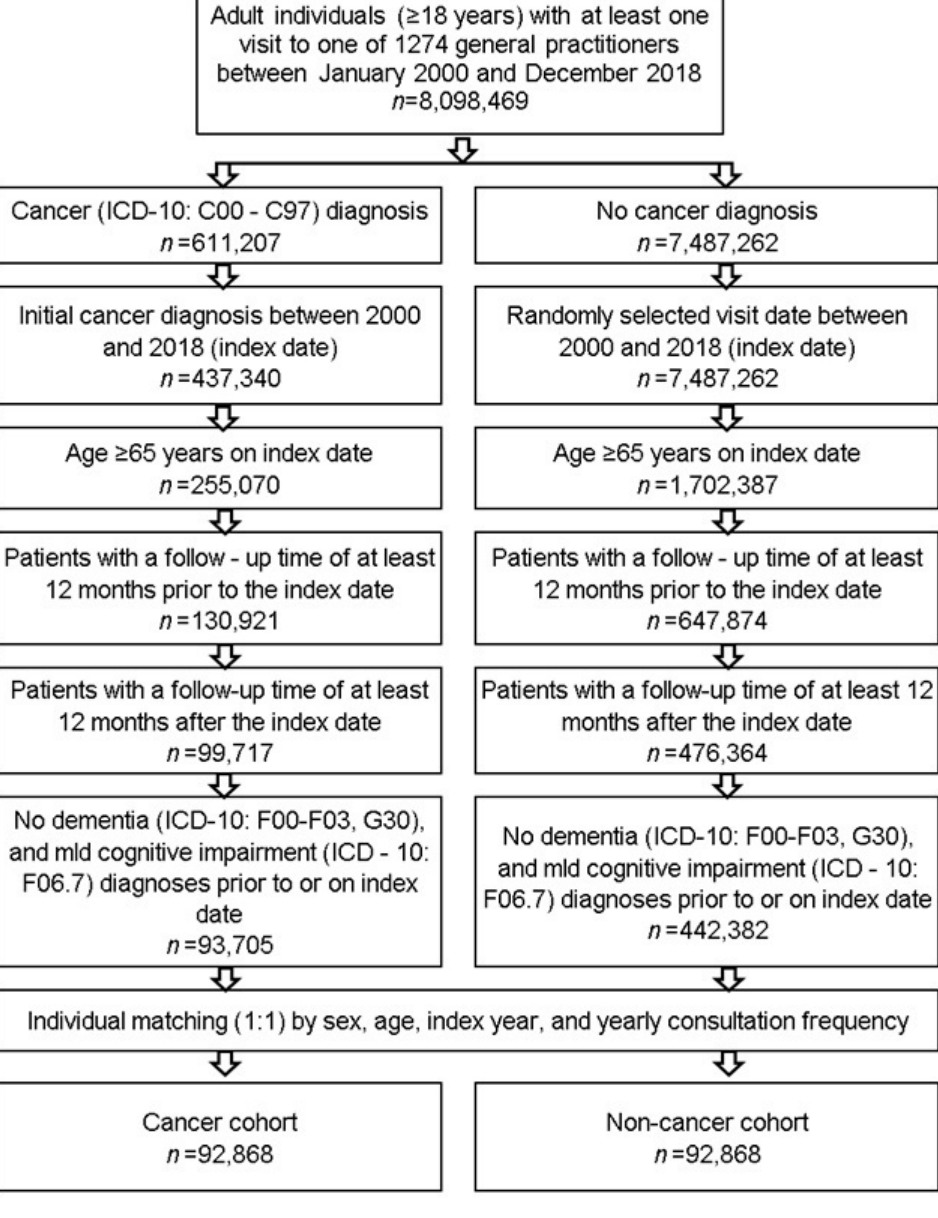
Figure 1. Selection of study patients.